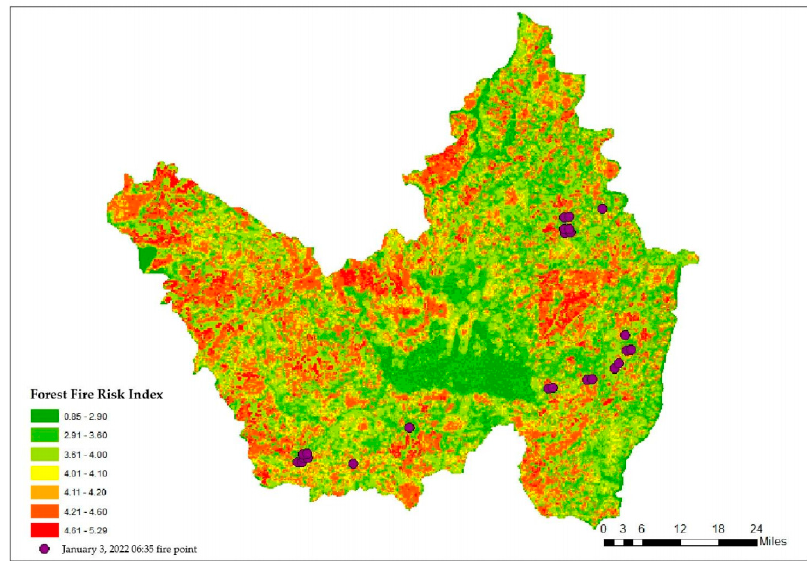
Figure 17. Map of landslide hazards in Yanyuan County based on multi-Graded Cascade Random Forest.